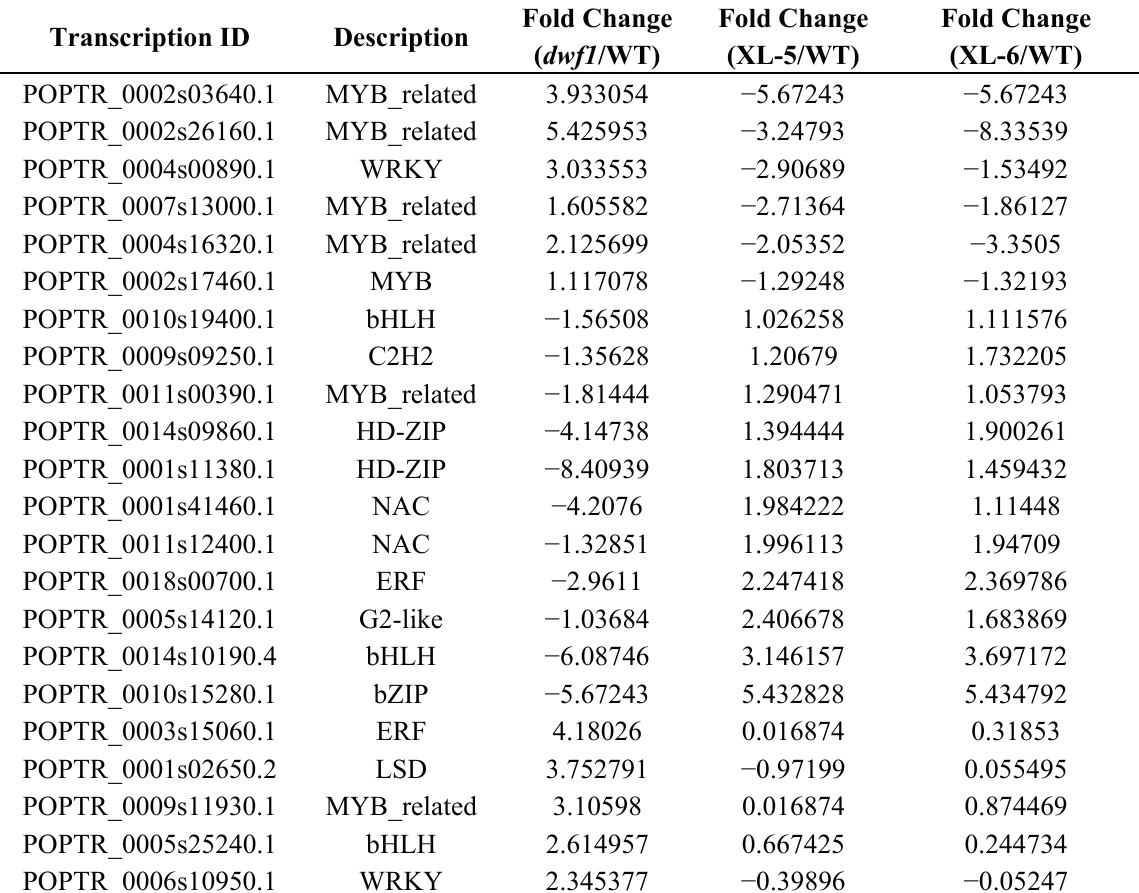
Table 3. Transcription factors in the 1246 dwf1 -specific differentially expressed